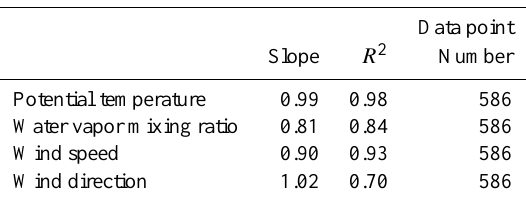
Table 3. Comparison result for meteorological variables between Melpitz radio-sounding measurements and WRF-Chem